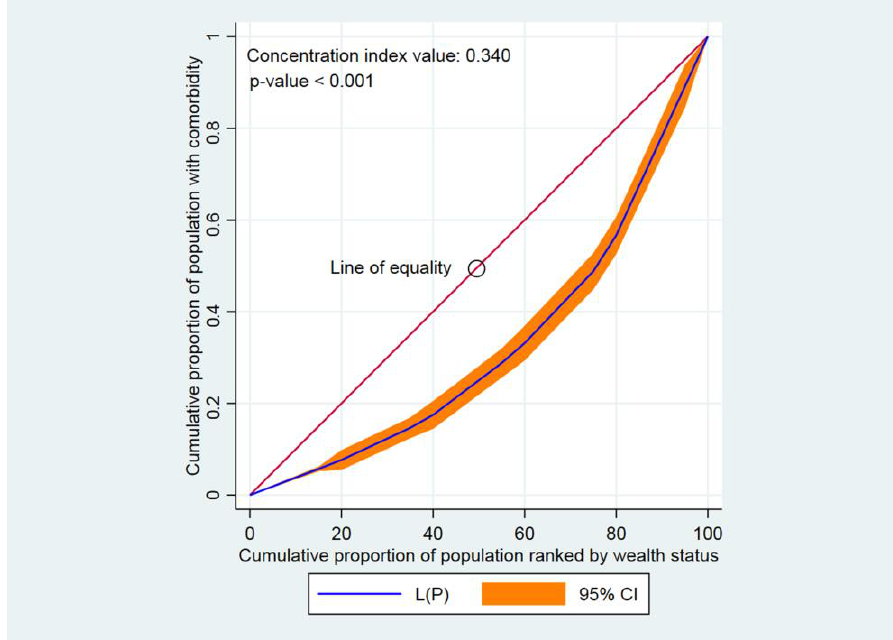
Figure 3. Concentration curve for comorbidity. Here, CI denotes confidence interval. Table 5. Decomposition of inequality measurement of